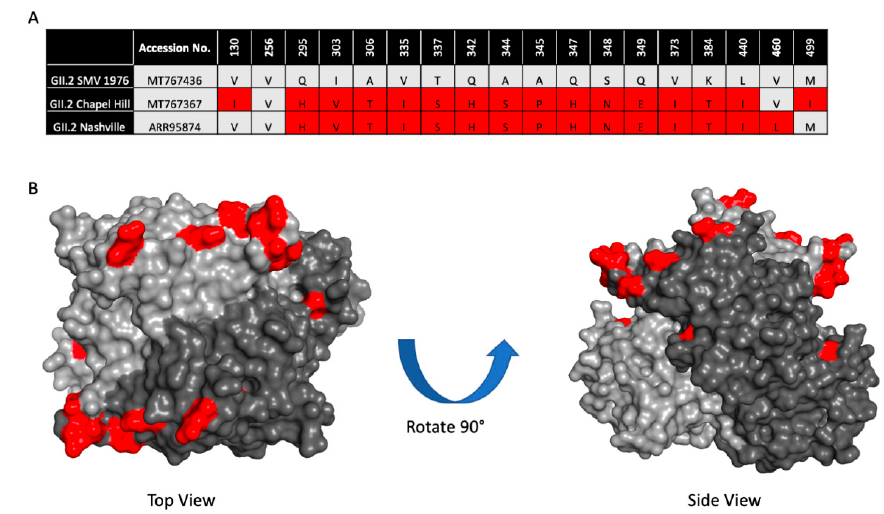
Figure 1. Sequence variation between 2017 GII.2 outbreak strains used in this study and prototype strain GII.2 Snow Mountain Virus (SMV) 1976. ( A ). Capsid amino acid di ff erences between ancestral GII.2 Snow Mountain Virus (GII.2 SMV 1976) and contemporary 2017 GII.2 strains Chapel Hill and Nashville are shown in red. ( B ) . Residues in contemporary GII.2 that are di ff erent from GII.2 SMV 1976 shown in panel A (red) mapped onto the P domain dimer (light and dark grey). VLP of the 2016–2017 GII.2 strains were synthesized (Supplementary Figure S1) and screened for reactivity to a set of monoclonal antibodies derived from mouse hyperimmunization with GII.2 1976 SMV VLP [31]. All monoclonal antibodies to the prototype strain retained binding to contemporary GII.2 strains (Figure 2A). Variation of EC 50 titers within each antibody for each VLP varied two-fold or less.